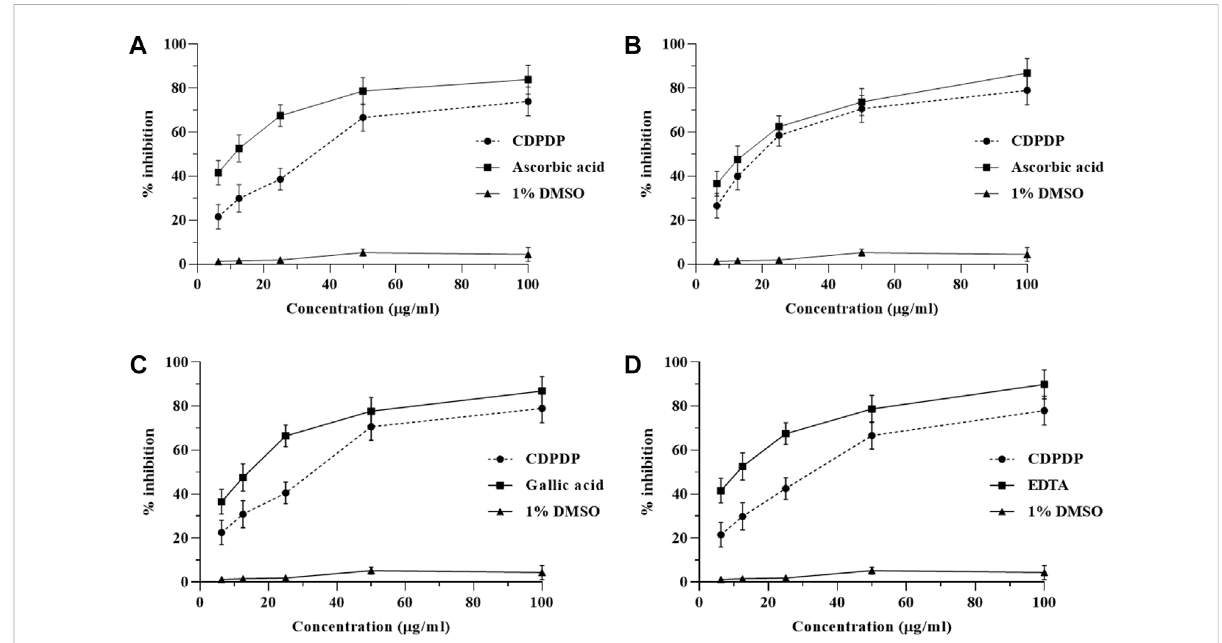
FIGURE 2 Representation of CDPDP antioxidant activity in vitro . Note: (A) DPPH radical scavenging properties, (B) NO C scavenging activity, (C) OH C scavenging activity, and (D) iron-chelating % inhibition. All values are represented as Mean ± SD ( n = 3).